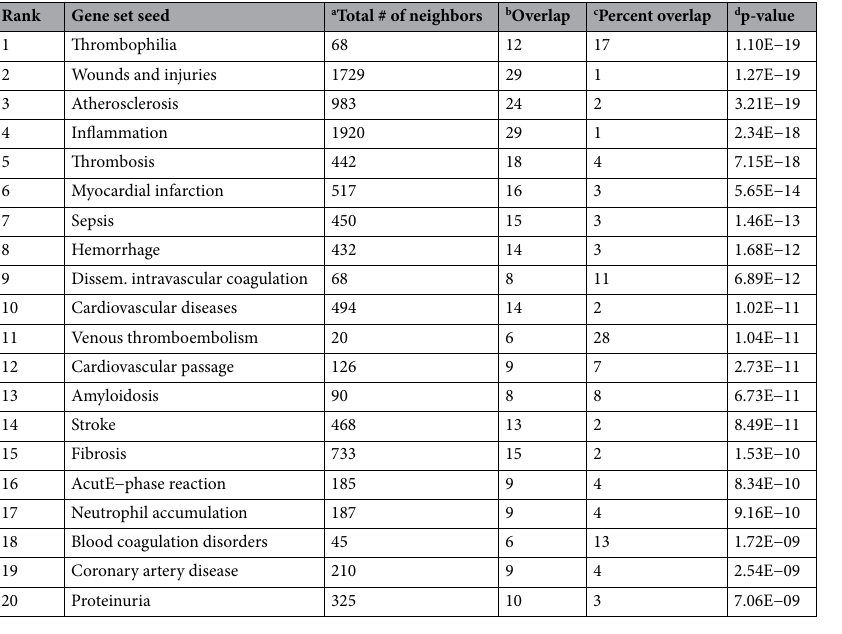
Table 4. Subnetwork enrichment pathways for serum proteins obtained from manatees sampled in the IRL. a The number of proteins in the specified pathway for human proteins. b The number of proteins from the data set that matched proteins in the pathway. c The calculated percent of proteins in the data set divided by the proteins in the human set times 100. d The probability that the pathway is